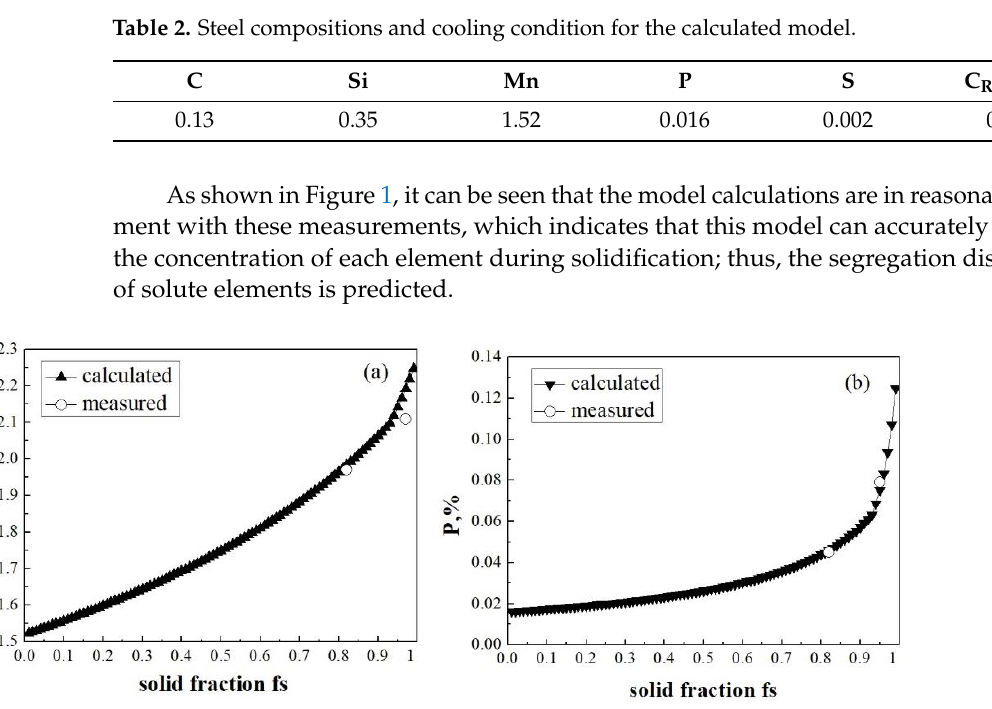
Figure 2. Macrograph of central crack on transverse section at etching print by hydrochloric acid (( a ) typical central cracks; ( b ) enlarged crack morphology; ( c ) crystal structure under optical microscope). After the typical central crack samples are mechanically ground, polished, and etched using picric acid, they are visualized using a video camera to observe the relation- ship between the crack and the columnar or equiaxed crystal. As shown in Figure 2b,c, the columnar crystal of crack samples is developed such that the length of the primary dendrite arm spacing reaches approximately 1000 μm. In addition, the central cracks all occur in the gap between two adjacent primary dendrites at the end of the columnar crys- tal zone, thus exhibiting typical cracking along the gap between the columnar crystals. Chemical compositions of the crack sample (Table 3) were detected using XRF (sequential X-ray fluorescence spectrometer, ZSXPrimus IV). Table 3. Chemical compositions of crack sample (wt. %). Steel Grade